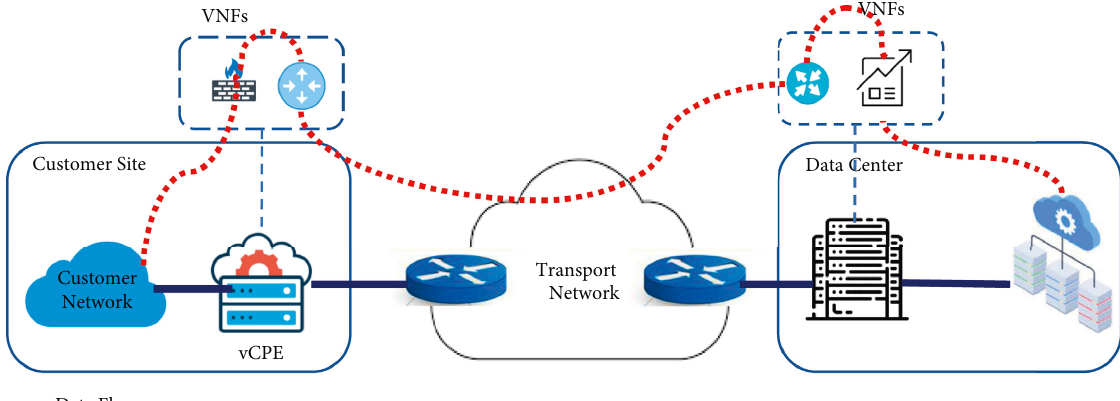
Figure 5: Customer premises equipment network, 2019 [41].